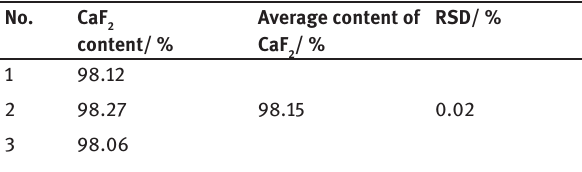
Table 5: Verification experiment